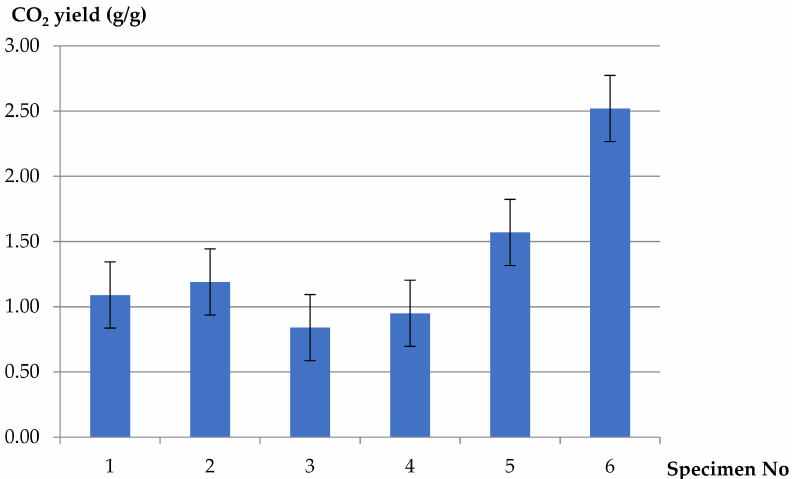
Figure 4. CO 2 yields (mass loss basis) for H07V-U cable, pure PVC and pure LDPE polymers at di ff erent ventilation